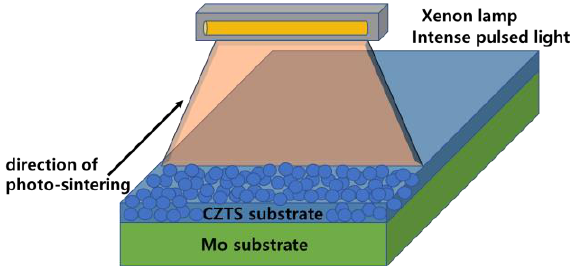
Figure 1. A schematic diagram of the intense pulsed light system.